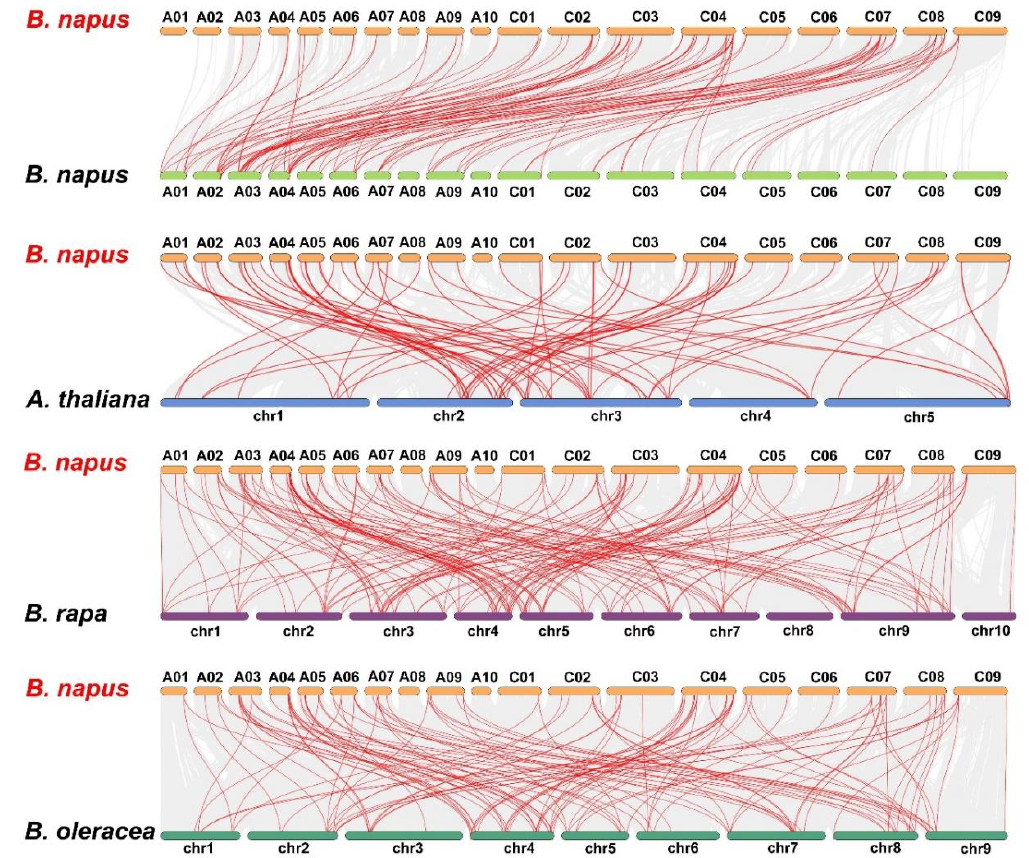
Figure 7. Synteny analysis of LBD genes in B. napus and three ancestral plant species. Gray lines in the background indicate the collinear blocks within B. napus and other plant genomes, while the red lines highlight the syntenic LBD gene pairs.